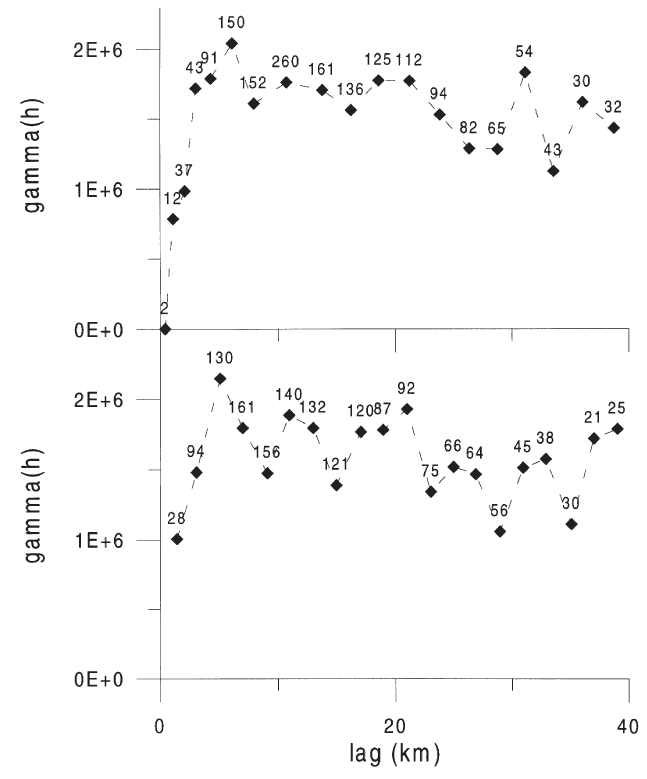
easier to fit to a theoretical model. See text for vector